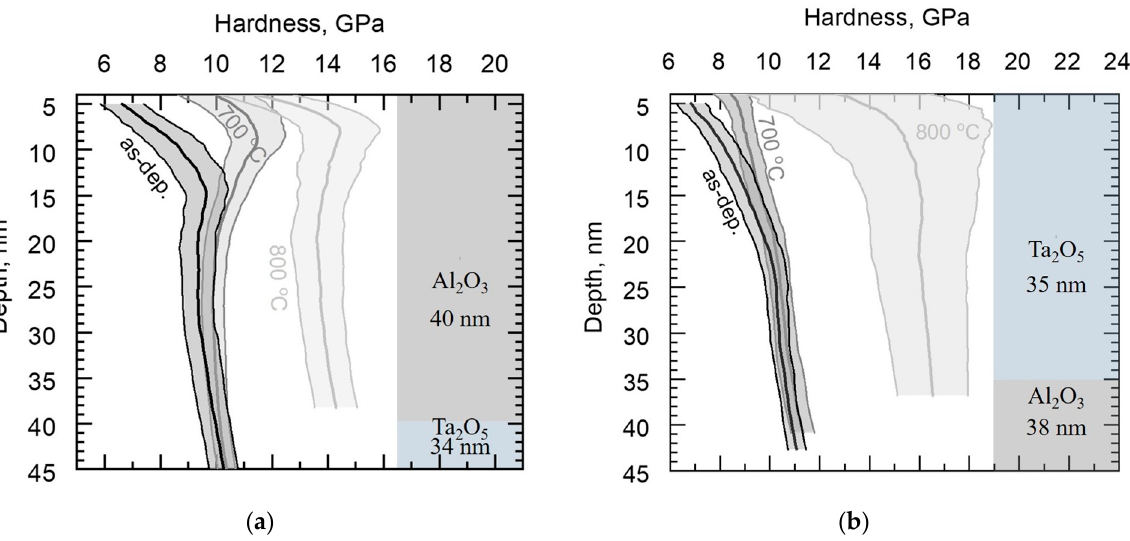
Figure 11. Average hardness along the film depth, with standard deviation of the layered structure of the film schematized on the right side of the panel: ( a ) as-deposited and annealed Al 2 O 3 /Ta 2 O 5 /Si; ( b ) as-deposited and annealed Ta 2 O 5 /Al 2 O 3 /Si.